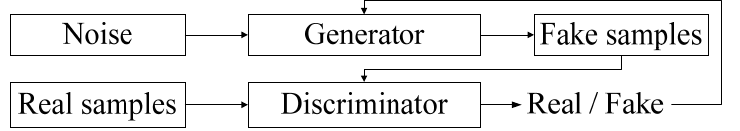
Figure 3. GAN architecture with both generator and